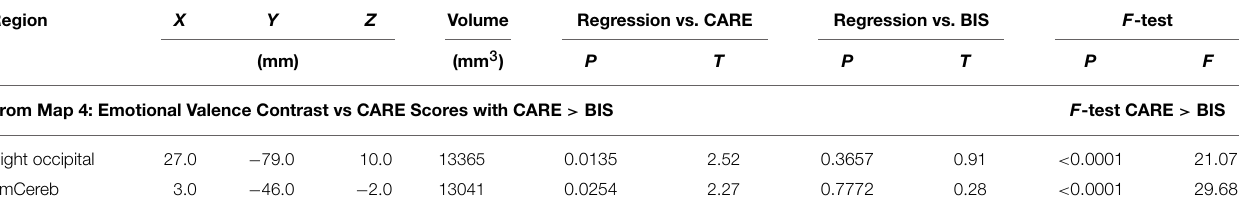
From Map 5: Emotional Valence Contrast vs BIS Scores with BIS > CARE